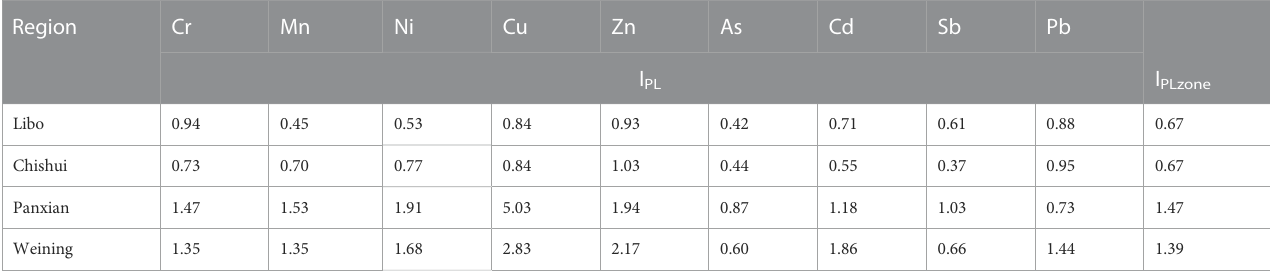
TABLE 2 Results of evaluation by the pollution load index.